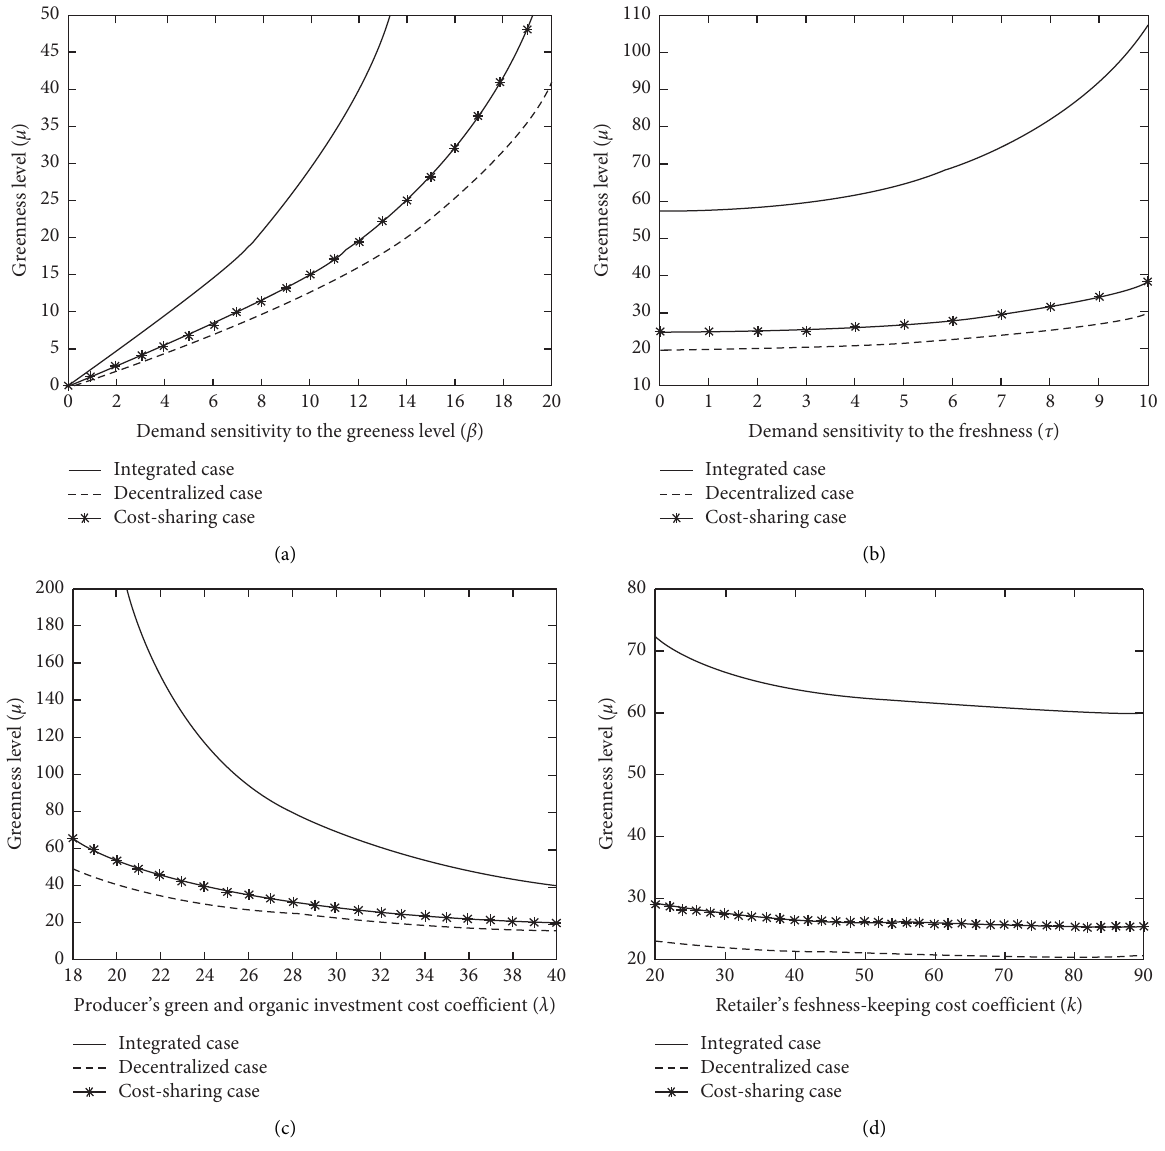
Figure 4: The impact of key parameters on the greenness level ( μ ) under different cases: (a) μ vs. β . (b) μ vs. τ . (c) μ vs. λ . (d) μ vs. k